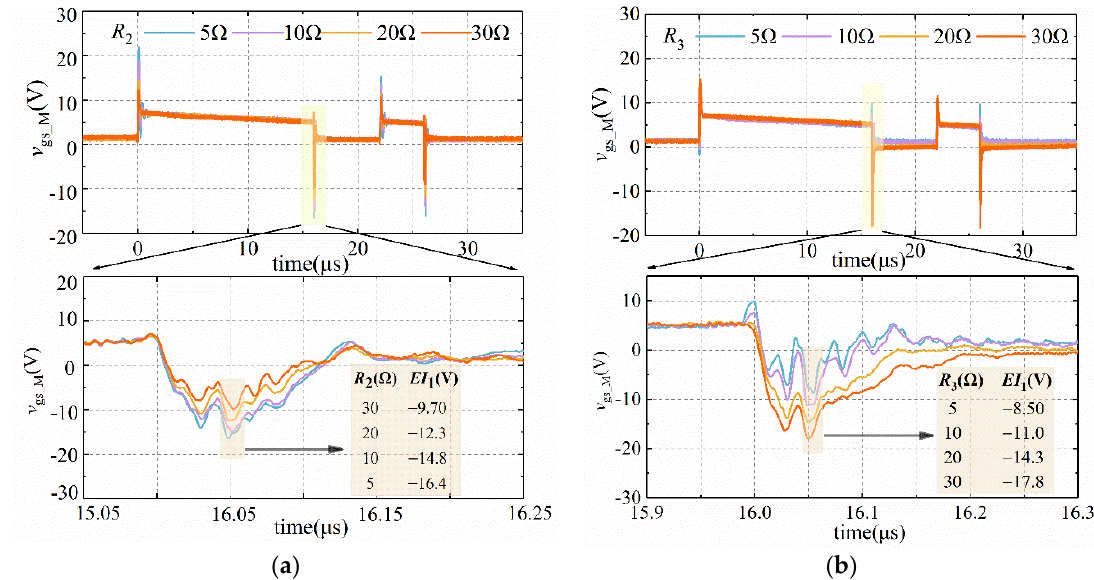
Figure 12. The variation of EI 1 with R 2 and R 3 . ( a ) With R 2 ; ( b ) with R 3 .